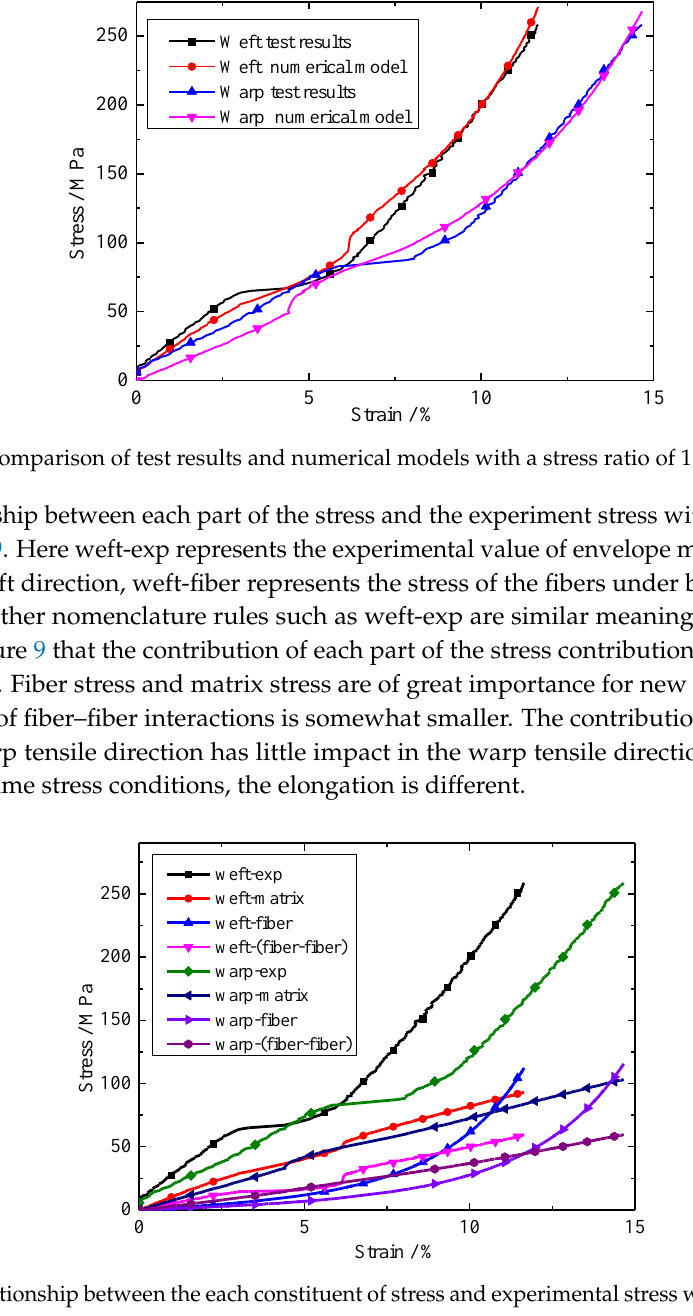
Table 4. Comparison of test results and predictive results under different ratios.